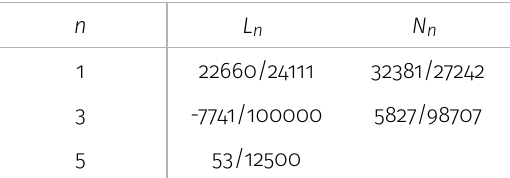
Table II. shows the numerical values of the coefficients L n L n L n and N n N n N n related to the Chebyshev polynomials P T P T P T and Q T Q T Q T expansions